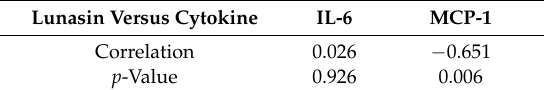
Table 2. Correlation of lunasin dosage and cytokine quantity.